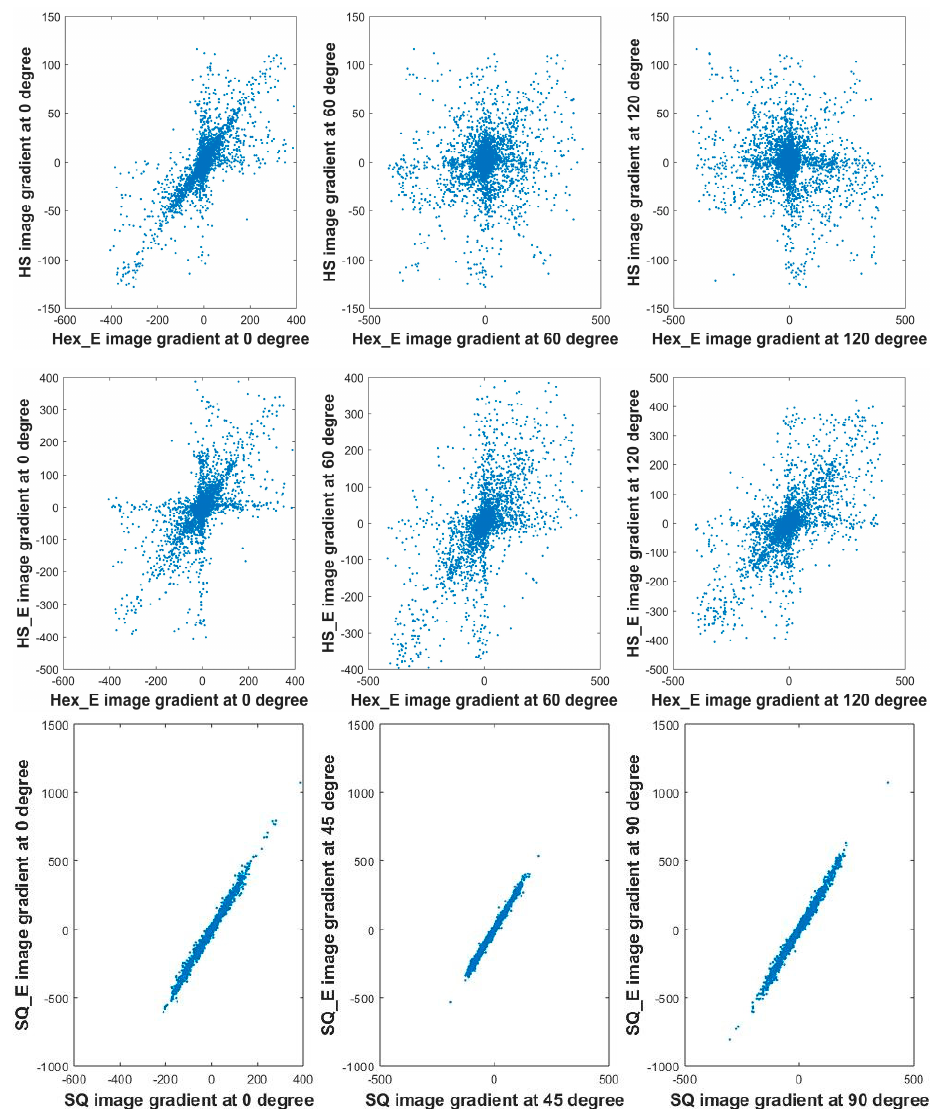
Figure 6. The gradients correlation between the Hex_E image (second column) and HS_E image (fourth column) shown in Figure 5 at directions of 0, 60 and 120 degrees (top row). And the gradients correlation between the SQ image (first column) and SQ_E image (third column) shown in Figure 5 at directions of 0, 45 and 90 degrees (bottom row).